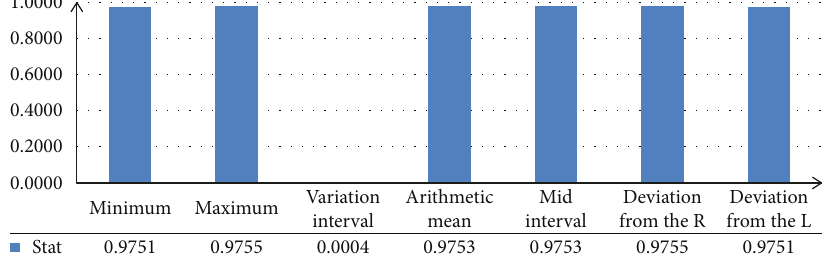
Figure 9: Operational availability statistics for period